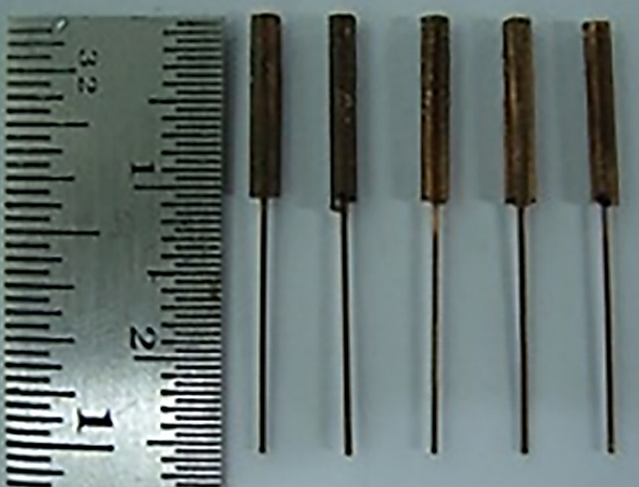
Figure 9. WTET fabricated high-aspect-ratio micro-pins (Reprinted/Adapted with permission from [43]. 2020, Elsevier. ©).